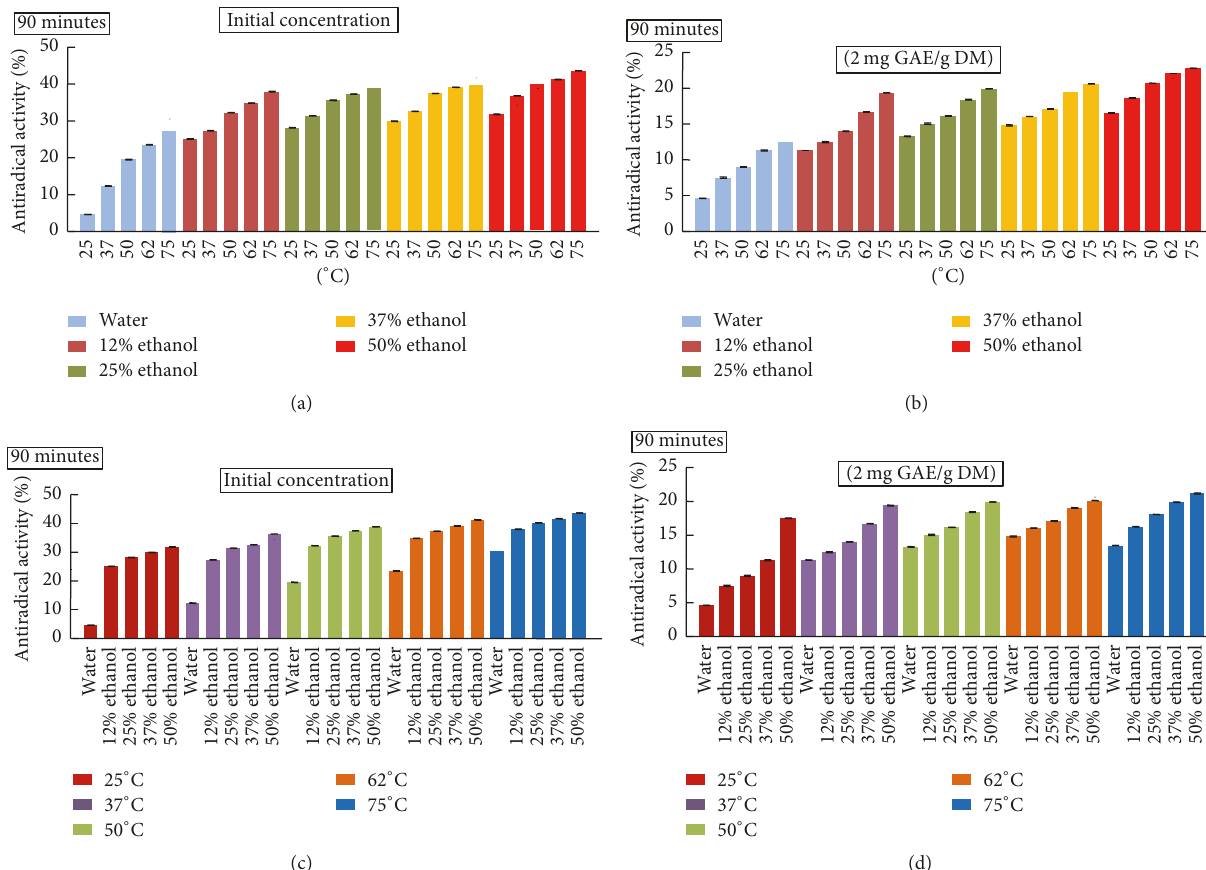
Figure 5: Antiradical scavenging capacity of apricot pomace (a, c) at their initial concentration and (b, d) at 2 mg GAE/g DM of polyphenols.